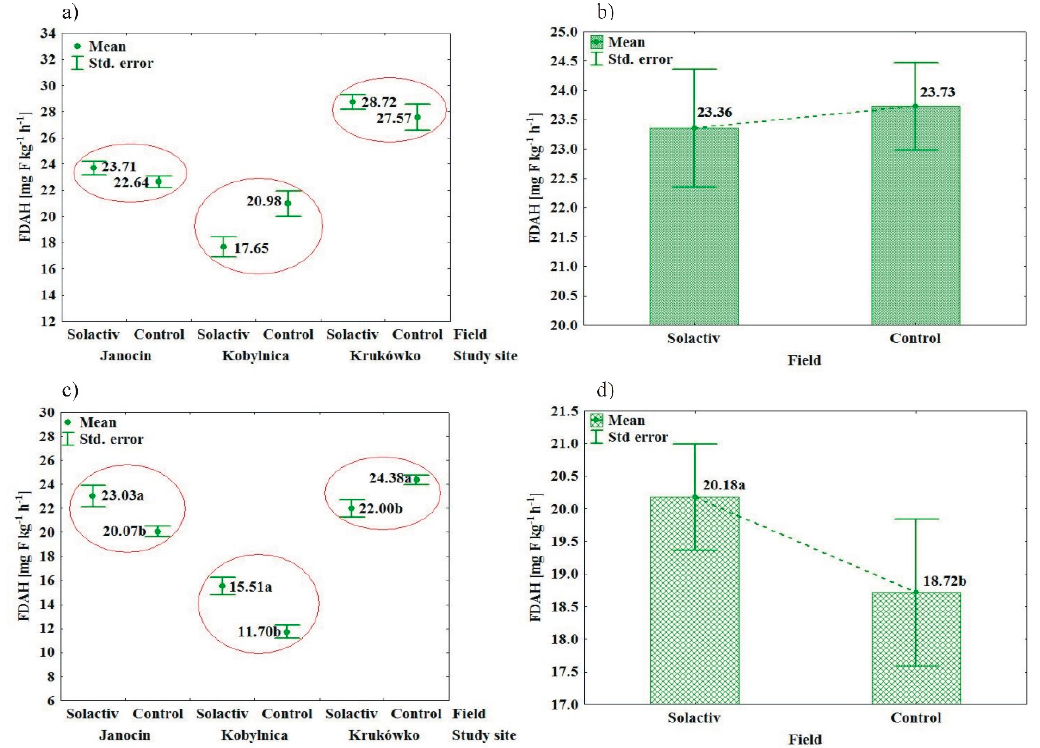
Figure 2. The FDAH level as affected by the tested conditioner. ( a ), ( b ) I sampling (before the maize was sown, n = 10); ( c ), ( d ) II sampling (after the maize was harvested, n = 10); ( b ), ( d ) the mean for all study sites ( n = 30). Data were analyzed using one-way ANOVA. Mean values for the conditioner and control followed by different letters are significantly different at p ≤ 0.05 according to Tukey’s HSD Test. The lack of letters indicates the lack of significance between means.